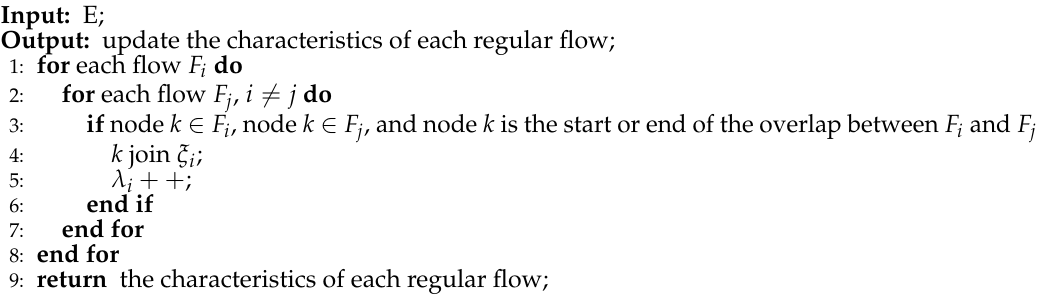
Algorithm 4 Intersection